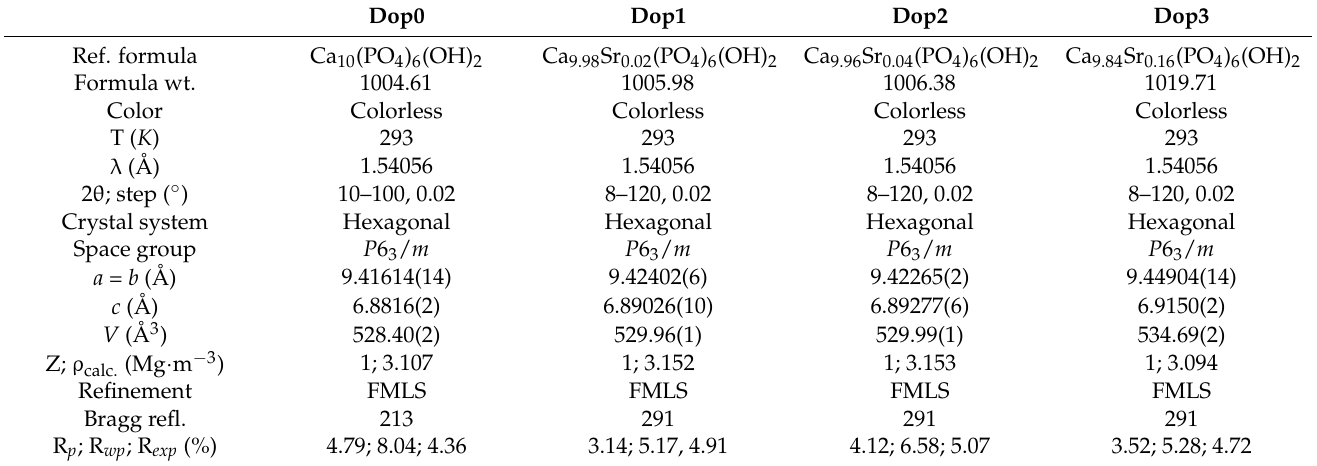
Table 2. Acquisition and structure refinement parameters for HAp samples. FMLS: Full-Matrix Least Square. Dop0 Dop1 Dop2